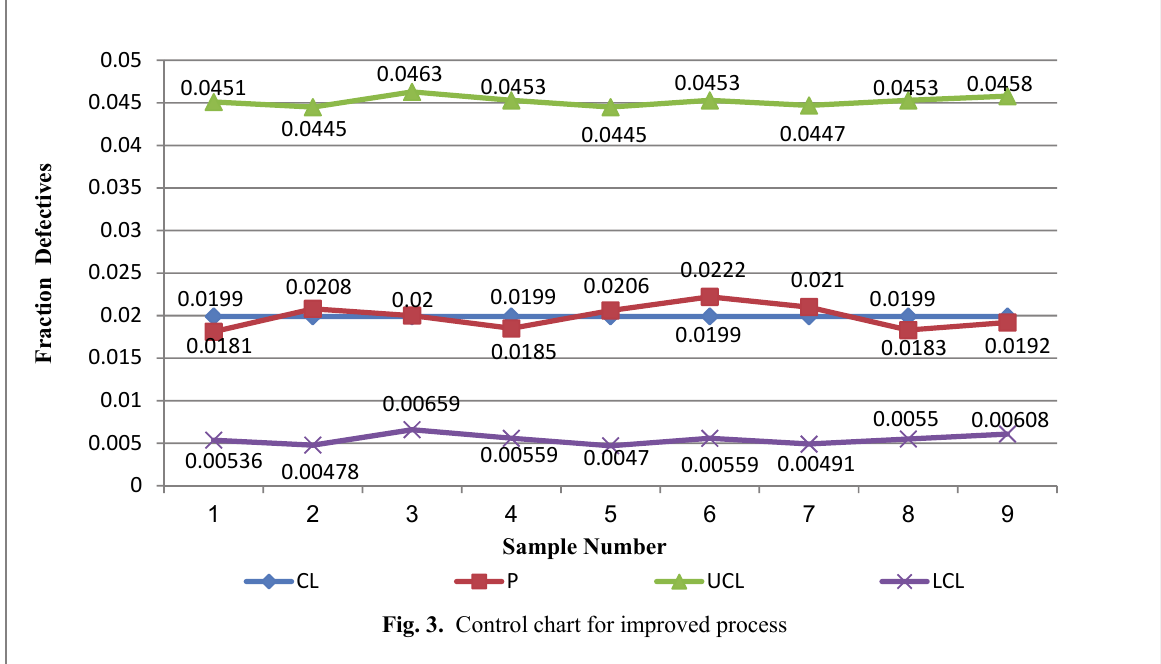
Fig. 3. Control chart for improved